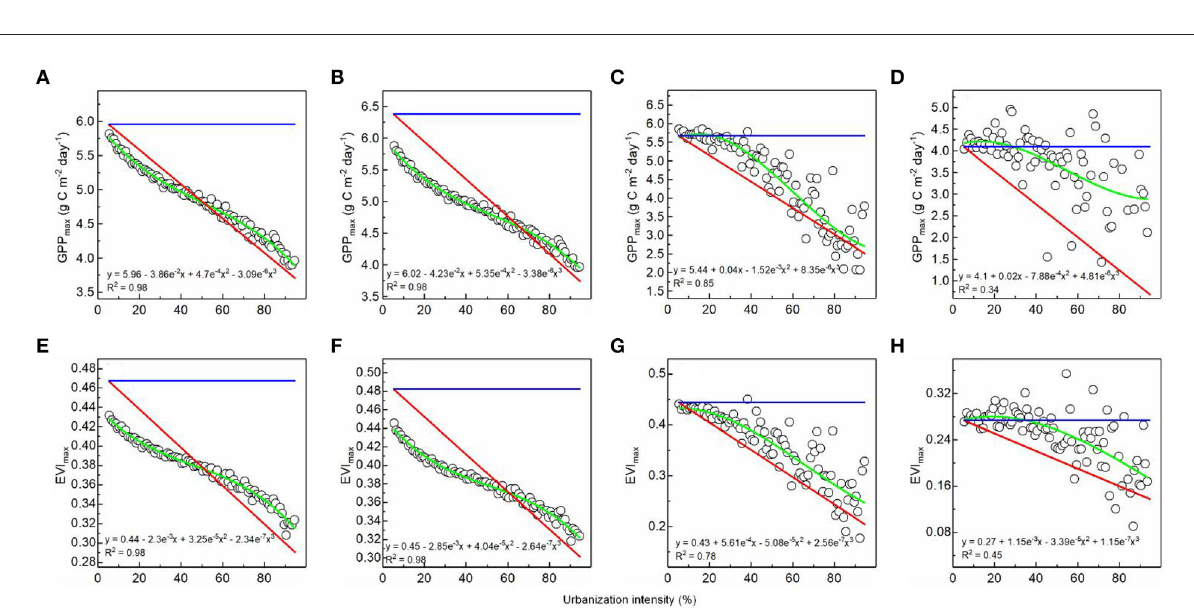
FIGURE3 The impacts of the urbanization gradient on peak photosynthetic rates in the whole area (A,E) , forest (B,F) , grassland (C,G) , and wetland (D,H) . The green, red, and blue lines are the cubic regression of the observed GPP max and EVI max (circles) with UI, the zero-impact line (V zi , GPP max , and EVI max without urbanization impact), and the background V v , respectively.